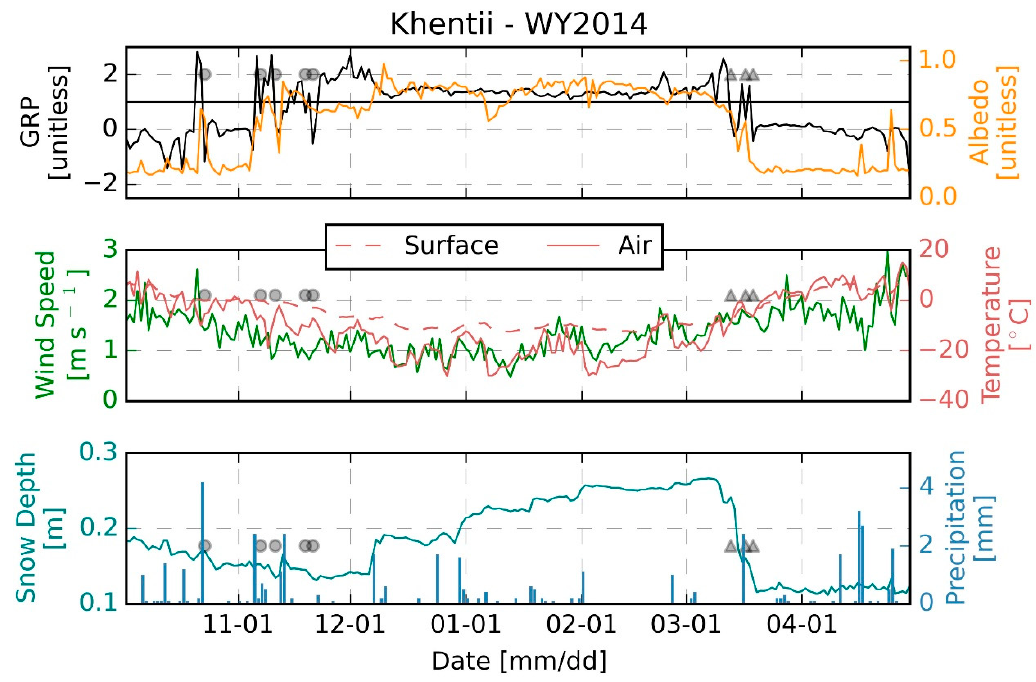
Figure 3. Satellite Gradient Ratio Polarization (GRP) time series plotted with in situ atmospheric and climatic parameters during selected Water Year (WY) 2014 from the Sugnugur valley (Khentii) site. The gray circles indicate fall surface melt events and the gray triangles indicate spring surface melt events.